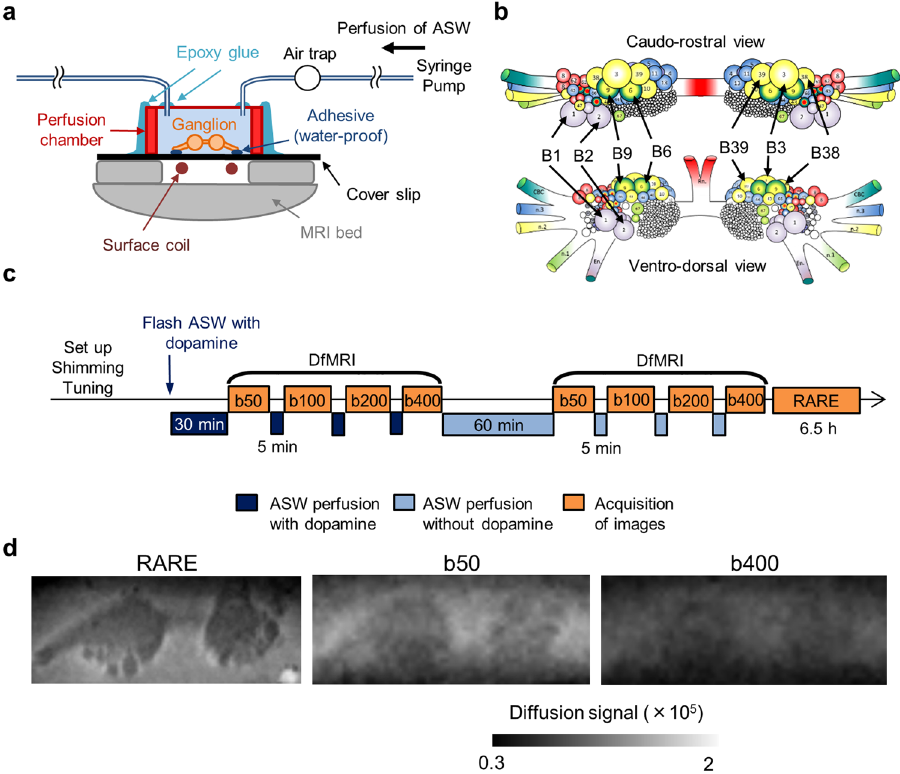
Figure 2. Experimental time course and perfusion system for MR microscopy. ( a ) Schematic diagram of the perfusion system used during MR microscopy experiments. ( b ) Schematic diagram of the buccal ganglia showing neurons B1, B2, B3, B6, B9, B38, and B39. ( c ) Time course of DfMRI experiments. 5 min-perfusion with dopamine + ASW or normal ASW was performed between diffusion acquisitions of each b-value